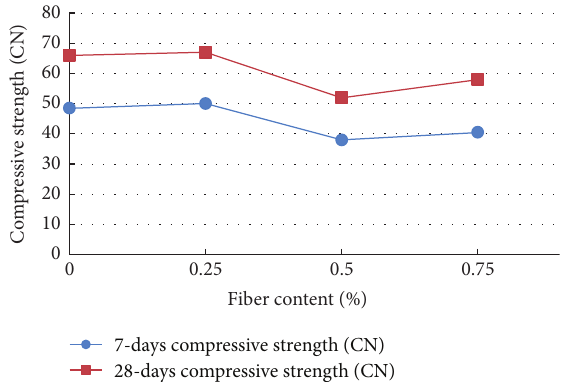
Figure 6: Mean compressive strength of